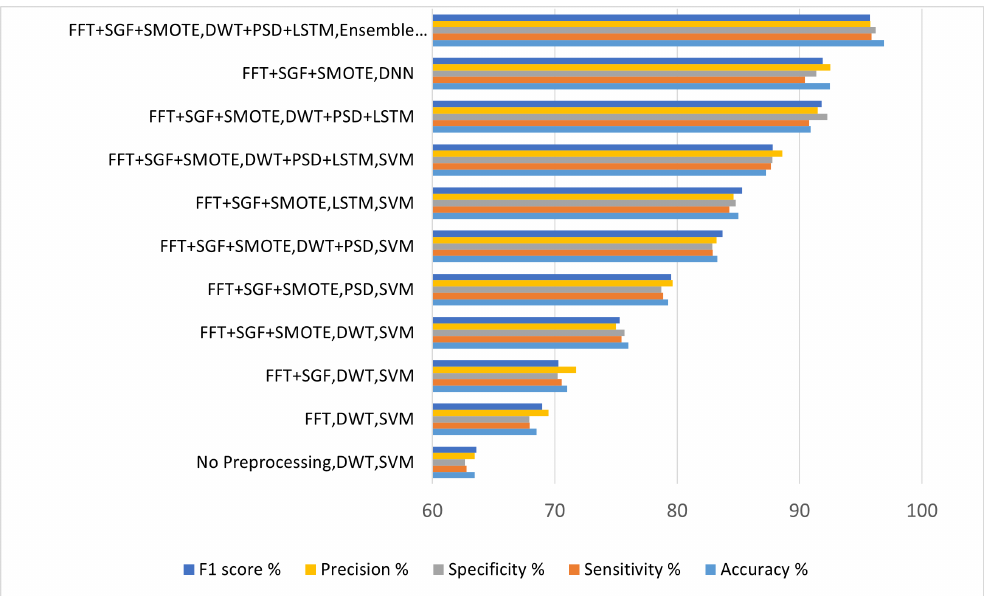
Figure 12. Comparison of results achieved for consumer choice recognition by using different